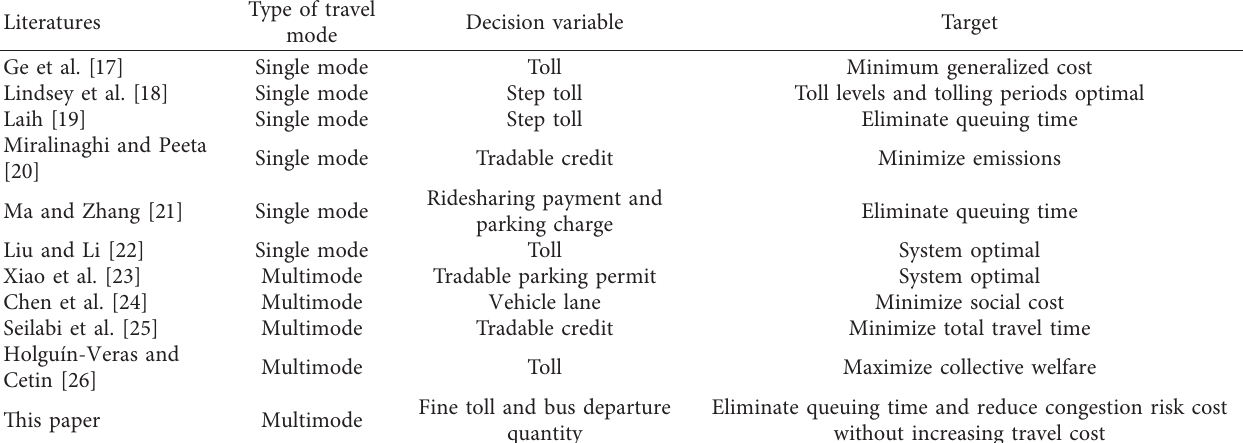
Table 1: Some research results of commuting bottleneck